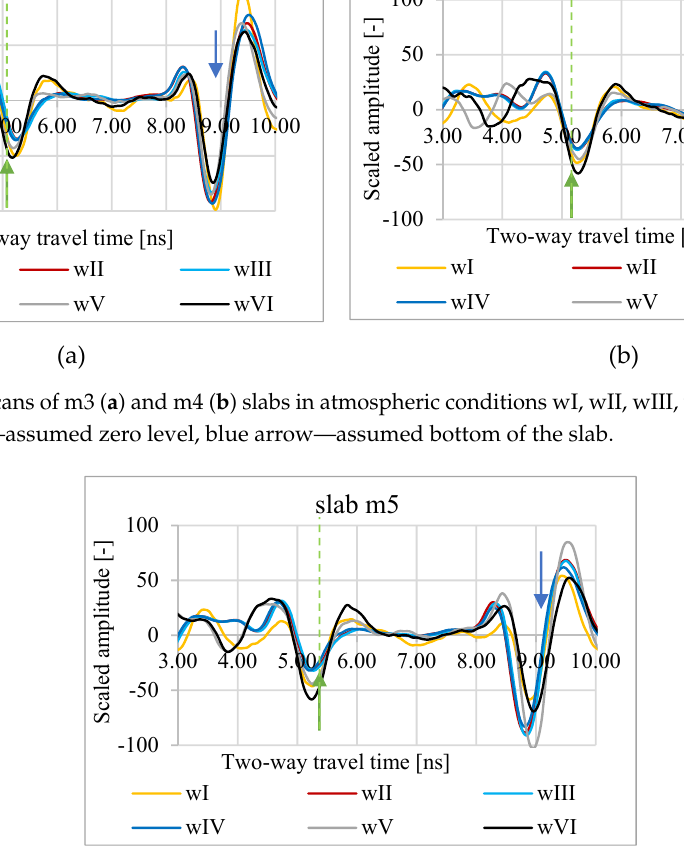
Figure 5. A-scans of m5 slab in atmospheric conditions wI, wII, wIII, wIV, wV, and wVI; green arrow—assumed zero level, blue arrow—assumed bottom of the slab.